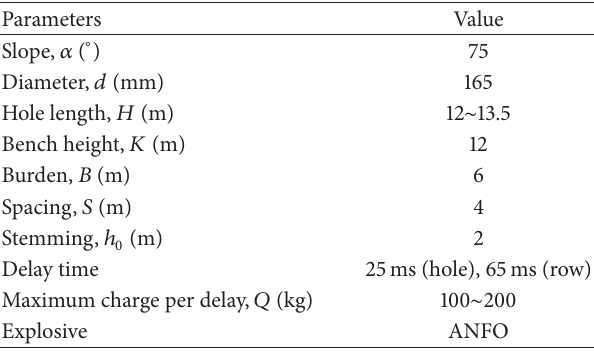
Table 1: General applied design parameters at the